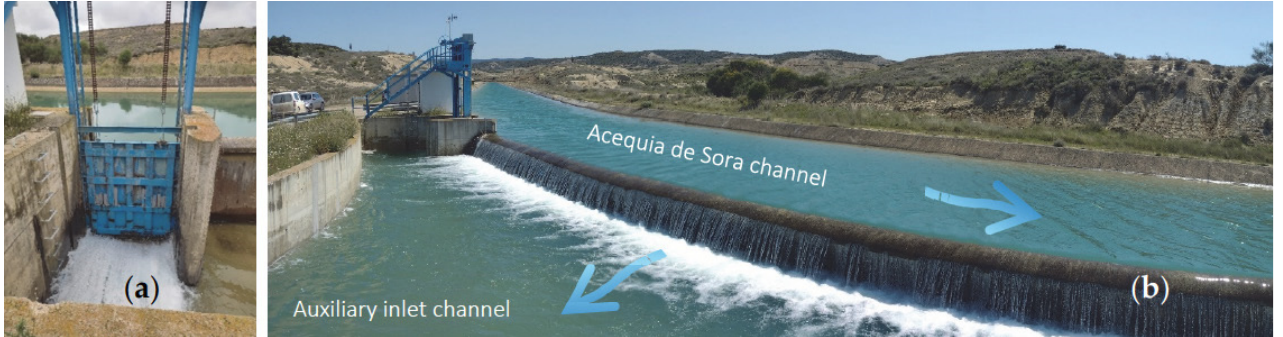
Figure 2. Intake work in the Acequia de Sora channel: ( a ) View from downstream of the flow control gate in operation. ( b ) Flow control structure on the left and side spillway from the Acequia de Sora to the auxiliary channel.